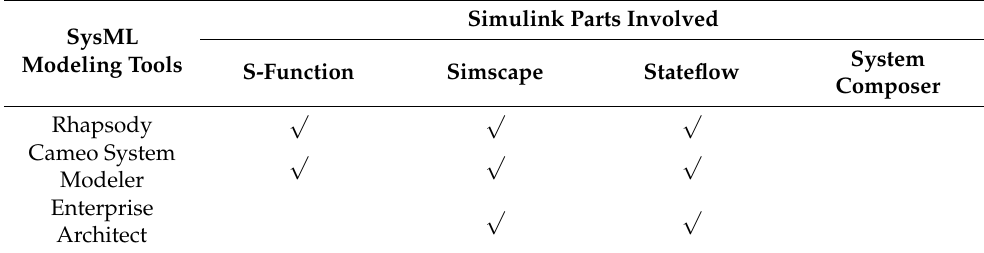
Table 1. Simulink integration capabilities in common SysML modeling